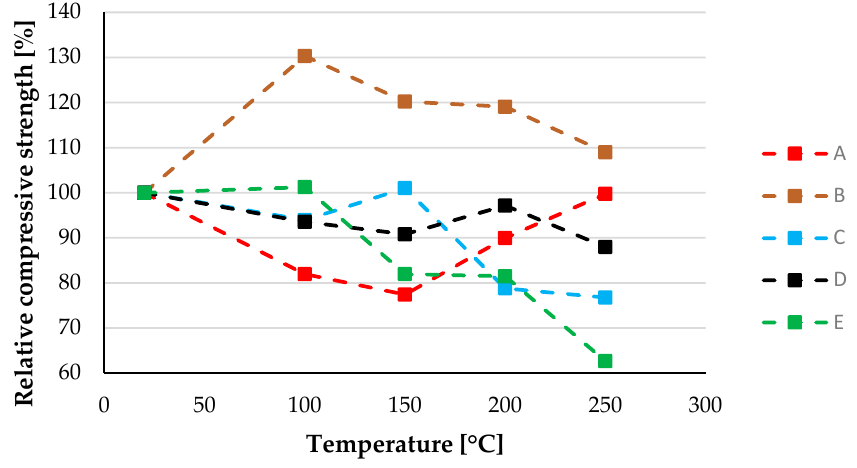
Figure 6. Compressive strength (%) vs. exposure temperature.